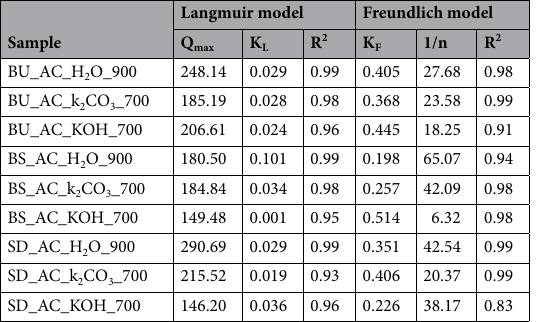
Table 5. Langmuir and Freundlich parameters for the adsorption of phenol over as-prepared porous carbon materials under the optimized conditions of phenol dose of 100 mg L −1 , temperature of 25 °C, and pH of 4.